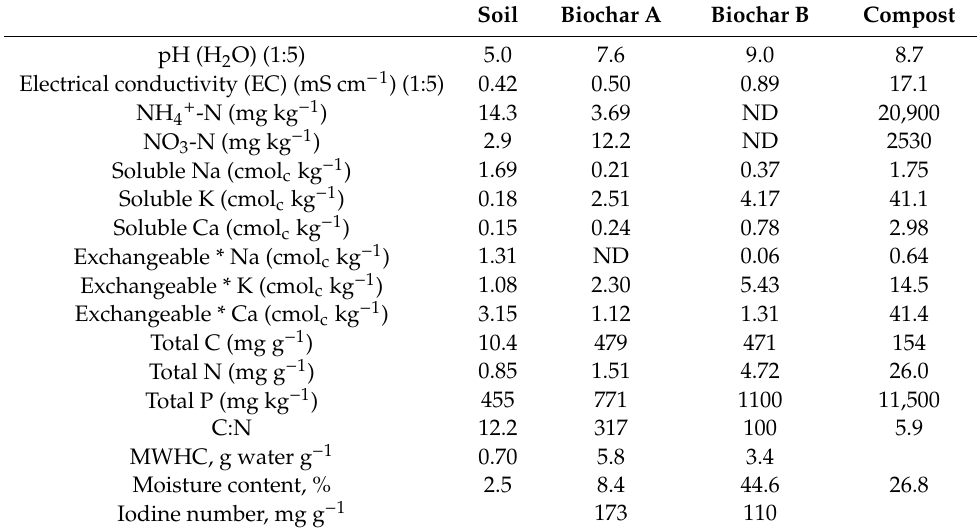
Table 1. Characteristics of soil and amendments used in the experiment.